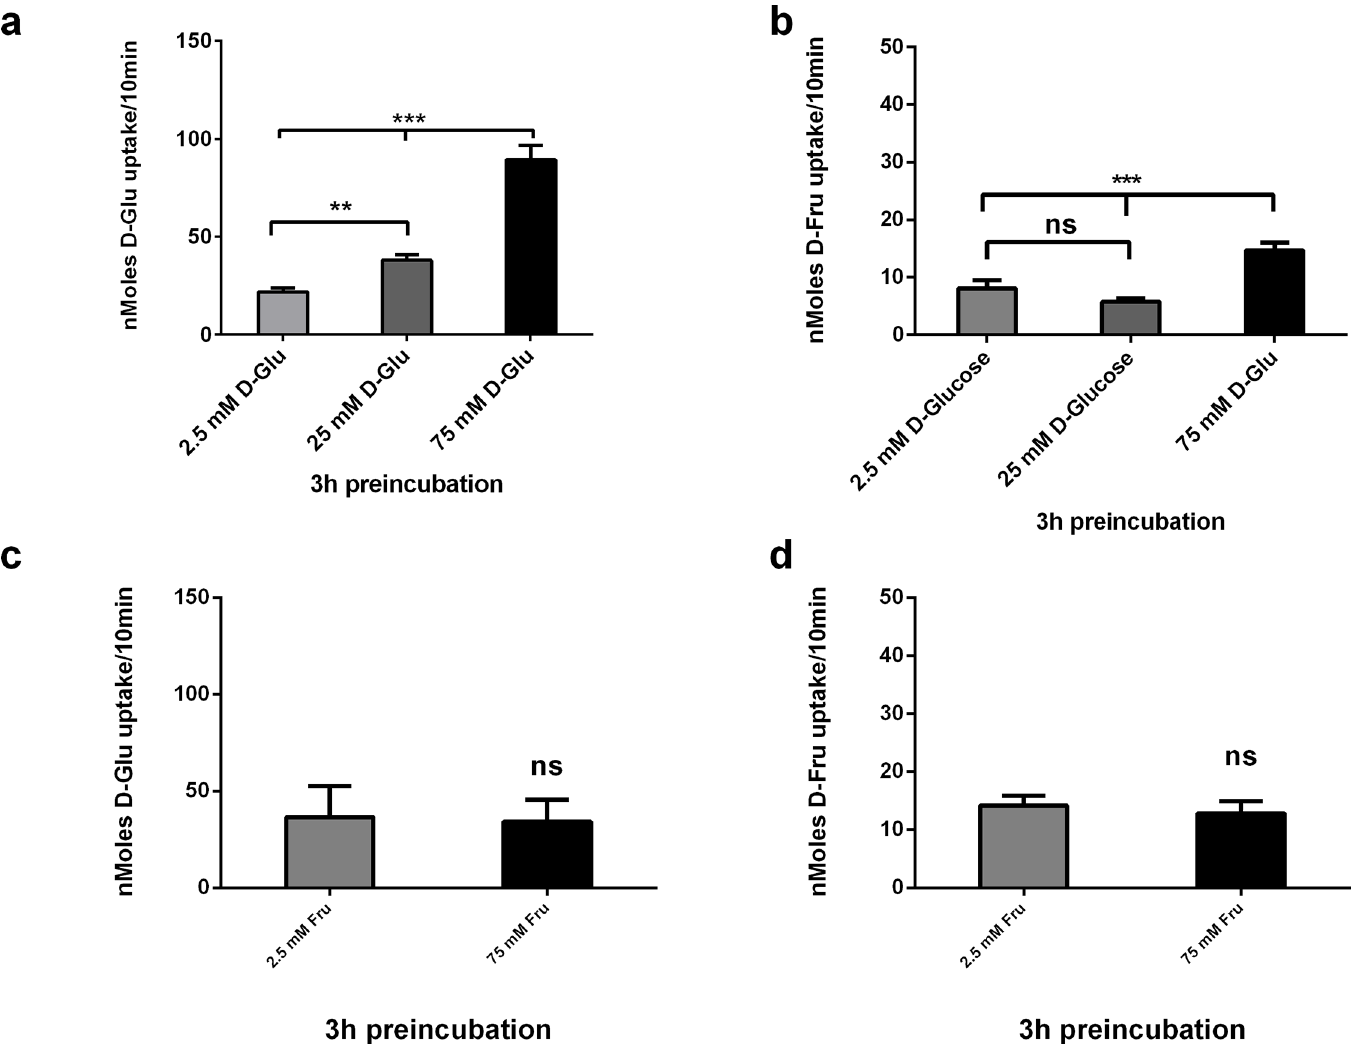
Fig 3. Acute effects of D-Glucose and D-Fructose on carrier mediated [ 14 C] 10 mM D-Glucose and D-Fructose uptake into Caco-2/TC7 cells. Caco- 2/TC7 cells grown for 21 days were incubatedwith 2.5, 25 and 75 mM D-Glucoseor D-Fructose for 3hrs, washedin sugar free KBS, followedby 10 mins exposureto (a and c) [ 14 C] 10 mM D-Glucoseand (b and d) [ 14 C] 10 mM D-Fructose. Cellularuptake of D-Glucoseand D-Fructose was measuredby radioactive scintillation spectrometry. Osmolarity was adjustedby addingMannitol.Uptake is corrected for simple diffusionof 10 mM [ 14 C] L-Glucose. Data are expressedas nMoles D-Glucoseor D-Fructose uptake/well/10min ± SD of n = 4 per condition. * P < 0.05, ** P < 0.01, *** P < 0.001, ns = not significant.